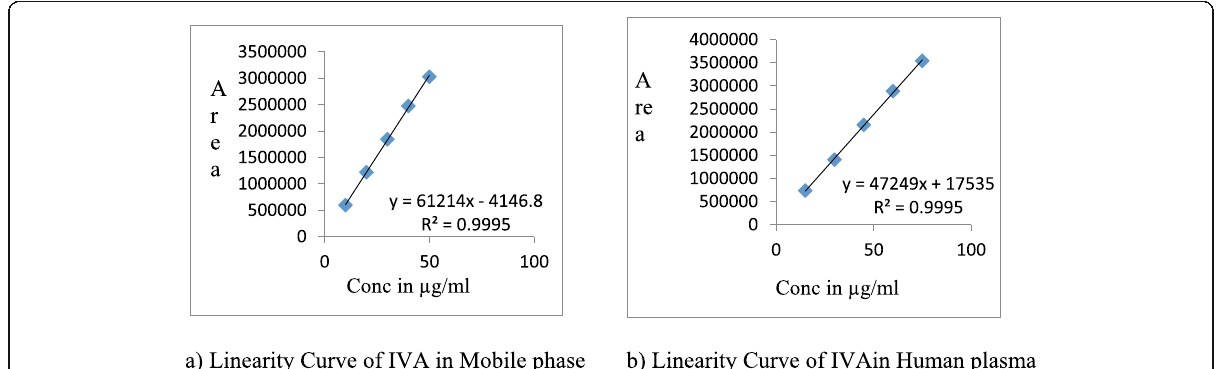
Fig. 7 Linearity plot of Ivacaftor in mobile phase and human plasma respectively. a Linearity curve of IVA in mobile phase. b Linearity curve of IVA in human plasma